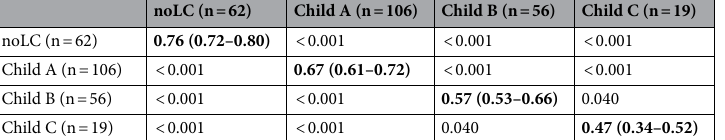
Table 4. T1 reduction rates. Pooled data from 1.5 to 3 T. In the diagonal (bold cells), T1 reduction rates for each liver group are presented as median and interquartile range (25%-quartile–75%-quartile). In the remaining cells, p-values calculated using Kruskal–Wallis test with Dunn’s multiple comparison corrected pairwise analysis are shown. noLC: no liver cirrhosis; Child A, B, C: Child Pugh group A, B,